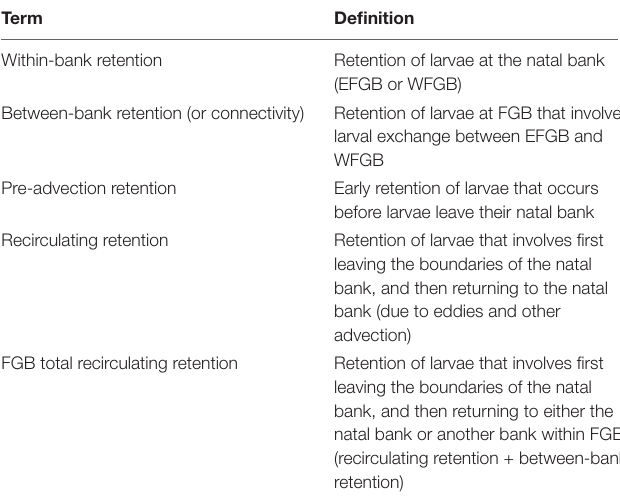
TABLE 1 | Definitions of modes of larval retention at